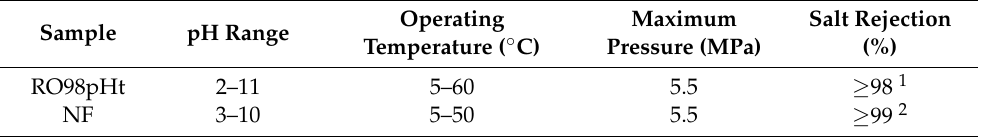
Table 6. RO and NF membrane